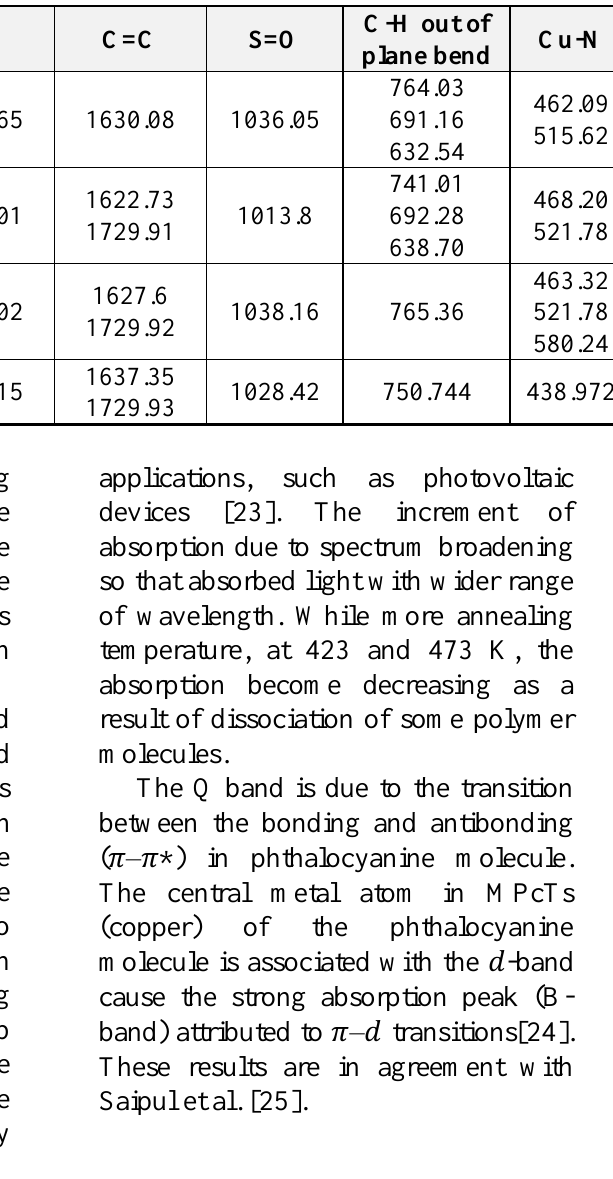
C-H out of Cu-N plane bend